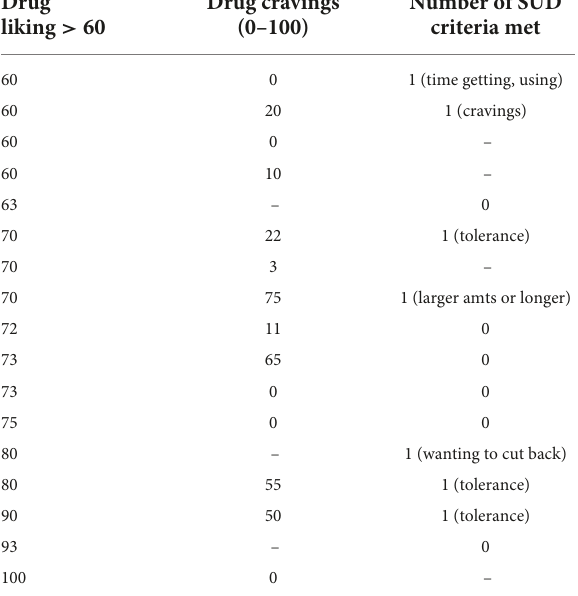
TABLE 1 Drug cravings and substance use disorder criteria in patients with positive ketamine drug liking ( n = 17)* (positive drug liking defined as liking > 60).